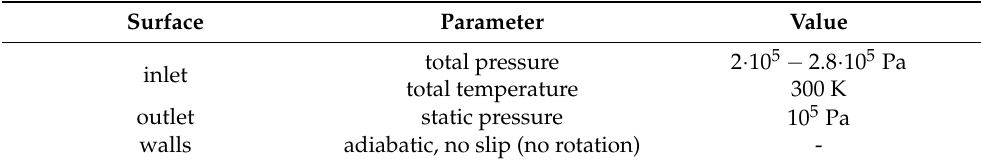
Figure 6. Computation domain. Table 1. Boundary conditions.